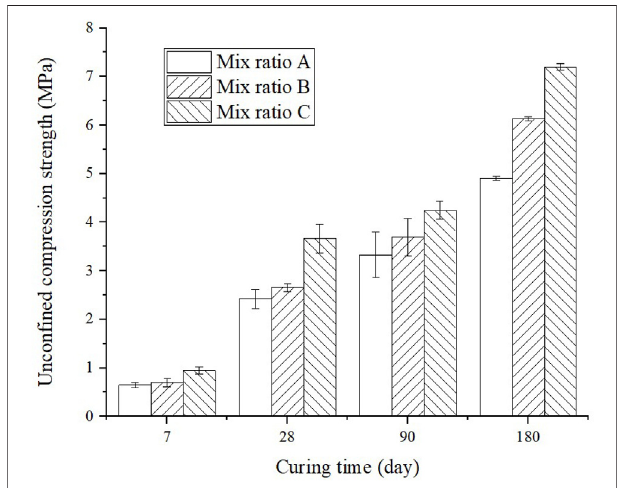
FIGURE 3 | Relationship between curing time and uncon fi ned compression